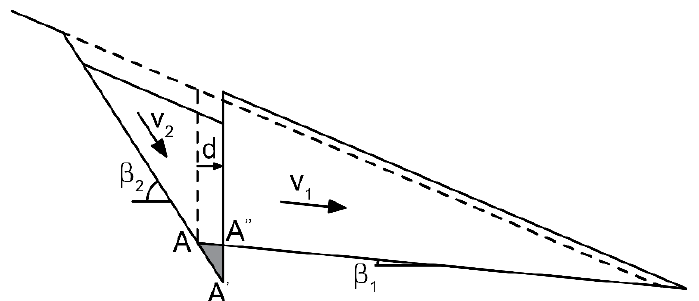
Figure 3. Schematization of the kinematical mechanism of the two blocks. The area AA’A”, the horizontal component of the soil displacement d , and the velocities of the wedges v 1 and v 2 are indicated. Lastly, substituting Equations (6), (7), and (13) in Equations (9)–(12), the following differential equation is attained: